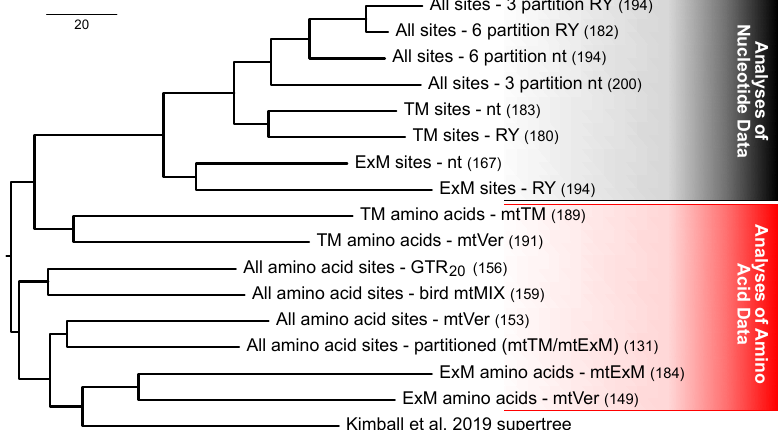
Figure 6. Dendrogram generated by clustering topological distances for the major lineages. We viewed the Kimball et al. [52] supertree, which is a summary of phylogenomic studies, as an esti- mate of the species tree and included for comparison to the mitogenomic trees. The parenthetical number that follows each mitochondrial tree is the matching distance to the Kimball supertree. To facilitate visualization, the root of the tree has been placed at the midpoint. The complete distance matrix is available in Supplementary File S4.